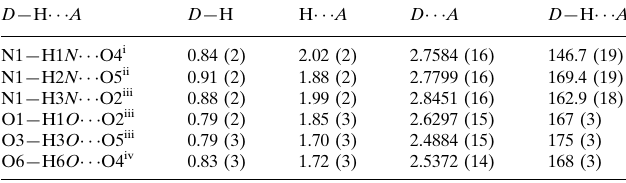
Hydrogen-bond geometry (A˚ , (cid:2)